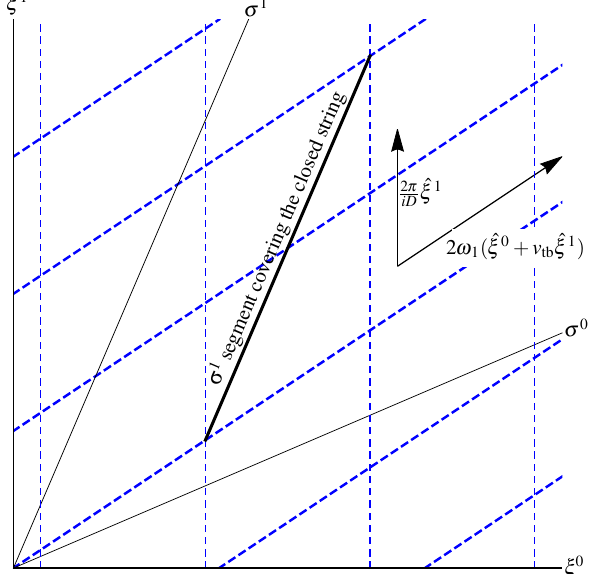
Fig. 17 The segment of σ 1 parametrizing a finite closed dressed ellip- tic string with D 2 < 0, as specified by the periodicity properties of the sine-Gordon counterpart. In the depicted example n dress = 1 and m dress = 2